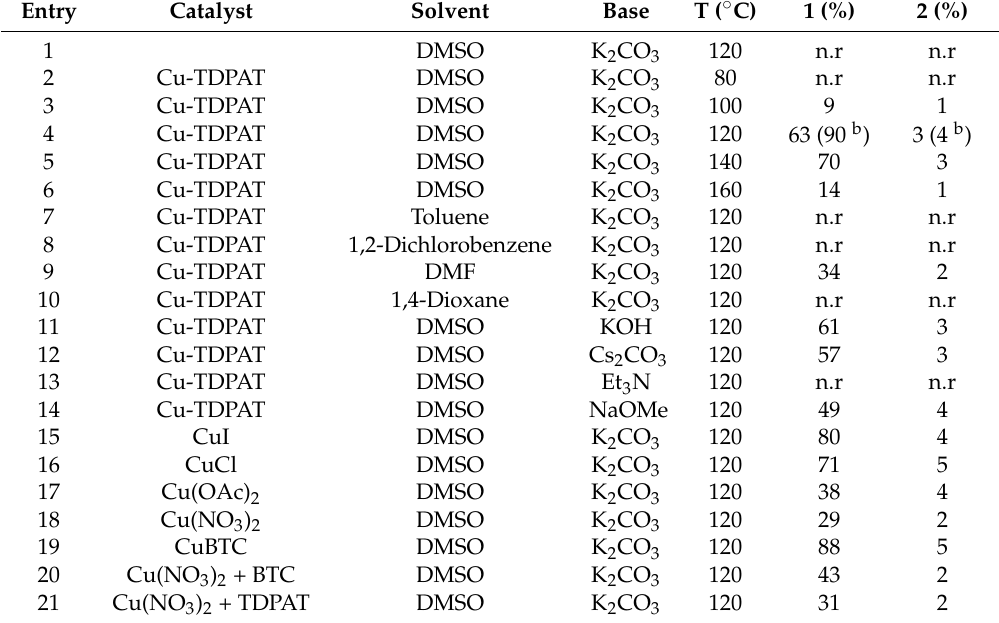
Table 1. Goldberg-type C–N coupling reaction of iodobenzene and 5-methyl-2-(1 H )-pyridone over copper MOFs and copper salts a .